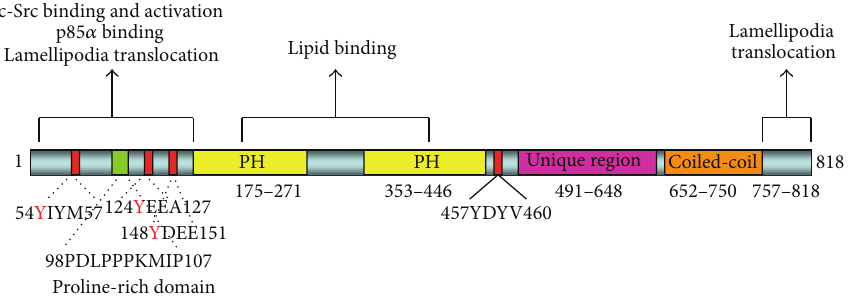
Figure 1: XB130 functional domains and motifs. The N-terminus of XB130 contains a proline-rich SH3 domain binding motif at aa 98–107 and three tyrosine containing SH2 domain binding sites at aa 54–57, aa 124–127, and aa 148–15. The first SH2 domain binding site contains a YXXM motif that binds the SH2 domain in the p85 𝛼 subunit of PI3K. In the middle region, there are two PH domains and another SH2 domain binding site at aa 457–460. The C-terminus contains a coiled-coil